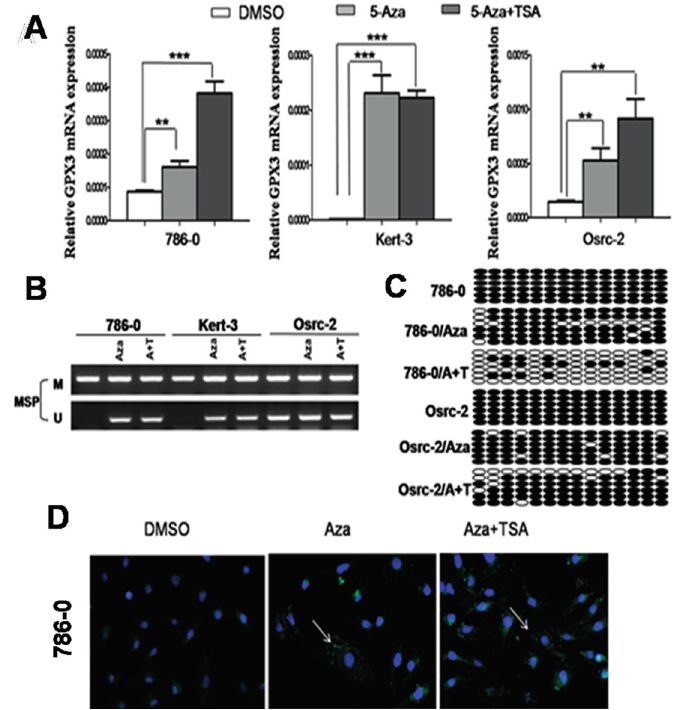
Figure 2. ( A , B ) Pharmalogic demethylation with 5-Aza alone or combined with trichostatin A (A + T) restored GPX3 mRNA expression and induced its demethyation in ccRCC cell lines. ** p < 0.01; and *** p < 0.001; ( C ) BGS analysis of Aza and A + T treated 786-O and Osrc-2 ccRCC cells. Each row represents one bacterial clone with one circle symbolizing one CpG site. Filled ovals indicate methylated. Open ovals indicate unmethylated; ( D ) Immunofluorescence staining of GPX3 protein in 786-O cells. Pharmalogic demethylation with 5-Aza alone or combined with trichostatin A (A + T) restored GPX3 protein expression in 786-O cells. Green pellet in the cytoplasm represents positive staining (indicated by